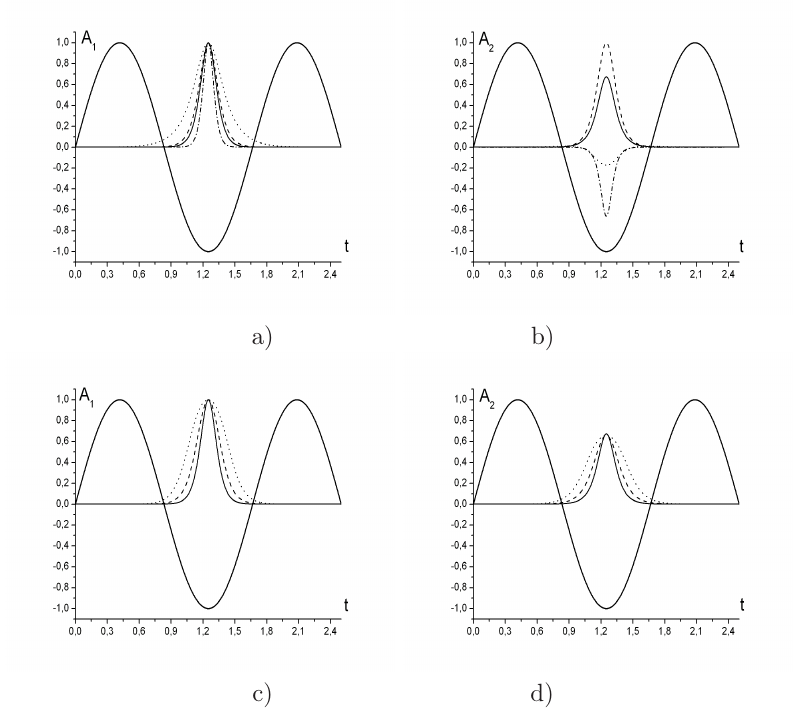
Figure 3. Shape of pulse for solitary wave on fundamental (a,c) and doubled (b,d) frequency corresponding to the first eigenvalue under the fixed value δ α = 0 (a,b) for n γ = 3 , δ γ = 0 (solid line), δ γ = 0 . 5 (dashed line), δ γ = 1 (dotted line), δ γ = 4 . 5 (dash-dotted line) or under the fixed value δ γ = 0 (c, d) for n α = 3 , δ α = 0 (solid line), δ α = 1 (dashed line), δ α = 1 . 5 (dotted